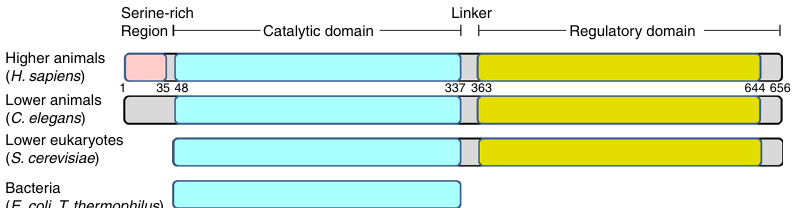
Fig. 1 Schematic representation of MTHFR. Domain organization of MTHFR orthologs across evolution. Numbers given represent approximate amino acid boundaries in human MTHFR corresponding to NP_005948. In brackets is shown representative species within each